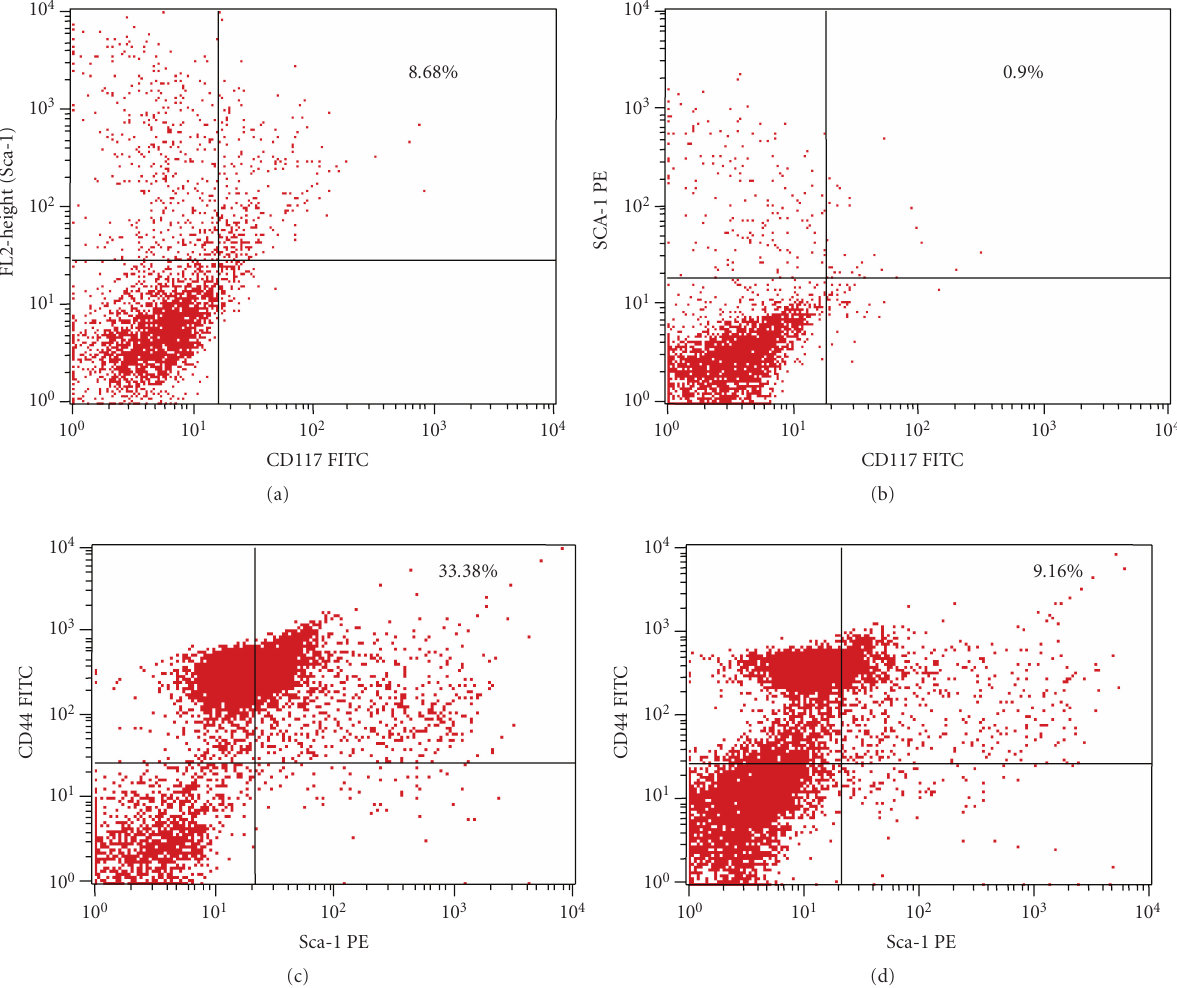
Figure 5: Phenotypical characterization of Sca1 and c-kit (CD-117) receptor expression by the bone marrow cells from normal (a) and Aplastic Anemic group (b) showed a quantitative depression in the primitive stem cell population in aplastic anemia. Phenotypical characterization of stromal progenitor cell marker (Sca1 and CD44) expression by the normal (c) and aplastic (d) bone marrow cells depicted depletion in the stromal progenitor cell population in aplastic